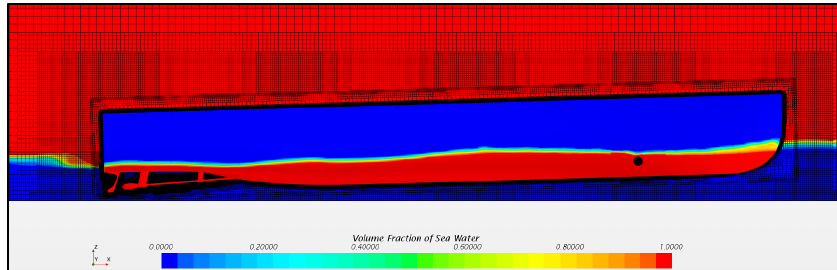
Figure 12. Phase distributions at Fr = 0.24 in shallow water.